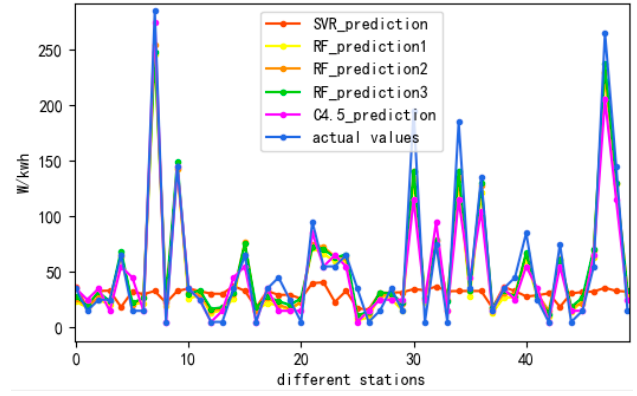
Figure 10. Prediction of charging capacity of station group.